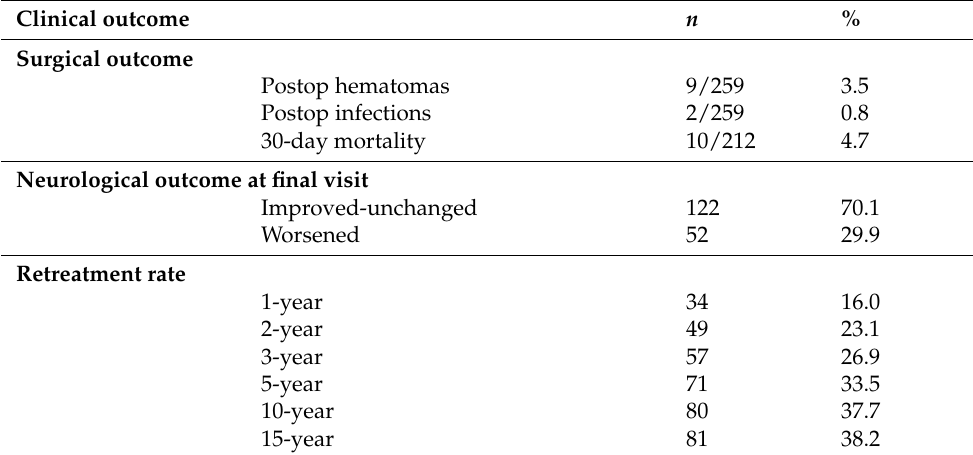
Table 2. Clinical outcomes.